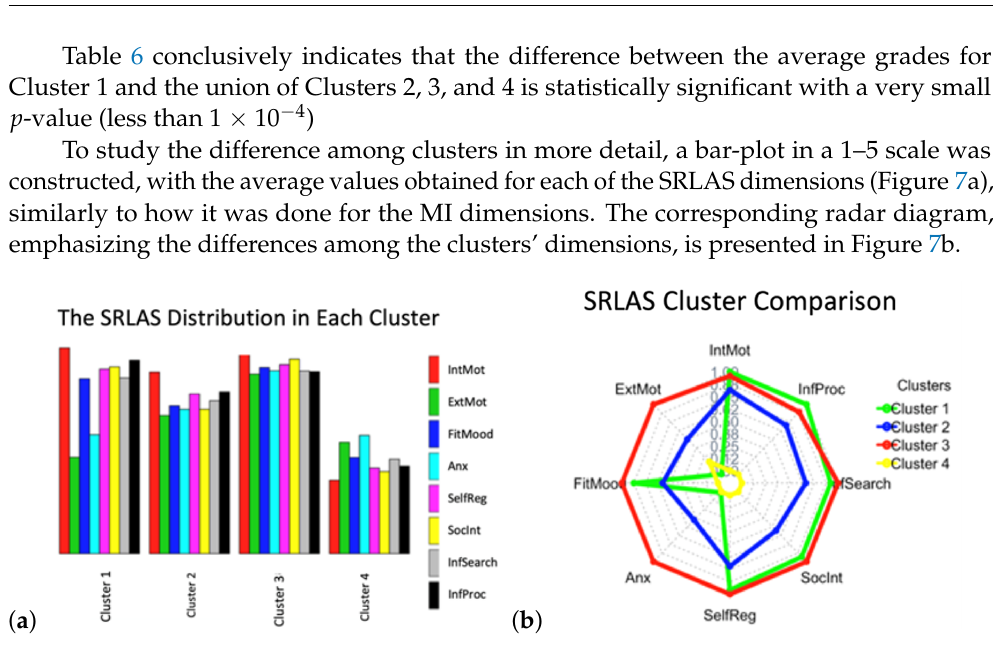
Figure 7. Comparing SRLAS clusters: ( a ) bar diagram; ( b ) normalized